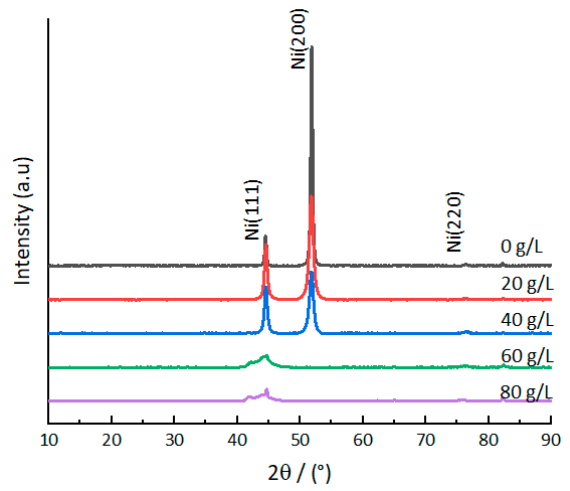
Figure 2. Effect of sodium citrate concentration on the X-ray diffraction (XRD) spectrum of the coatings.